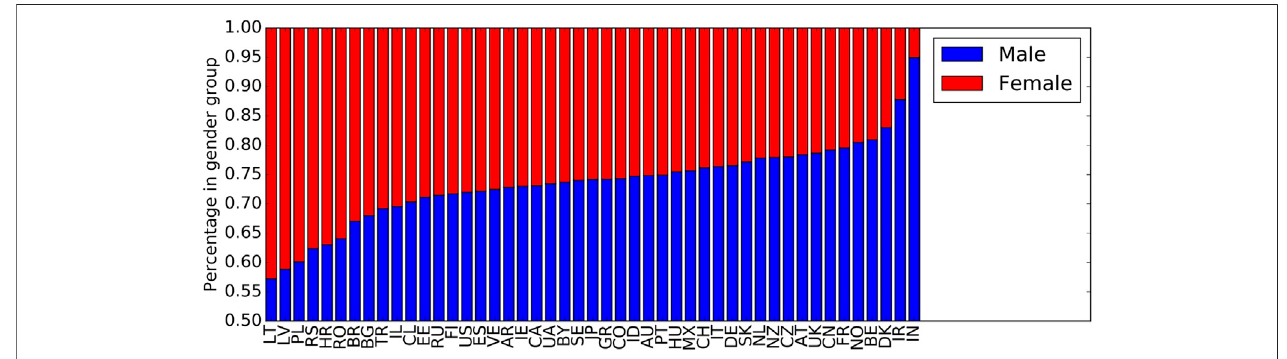
FIGURE 2 | Distribution of gender over countries. Countries are sorted in decreasing order of number of users from left to right.